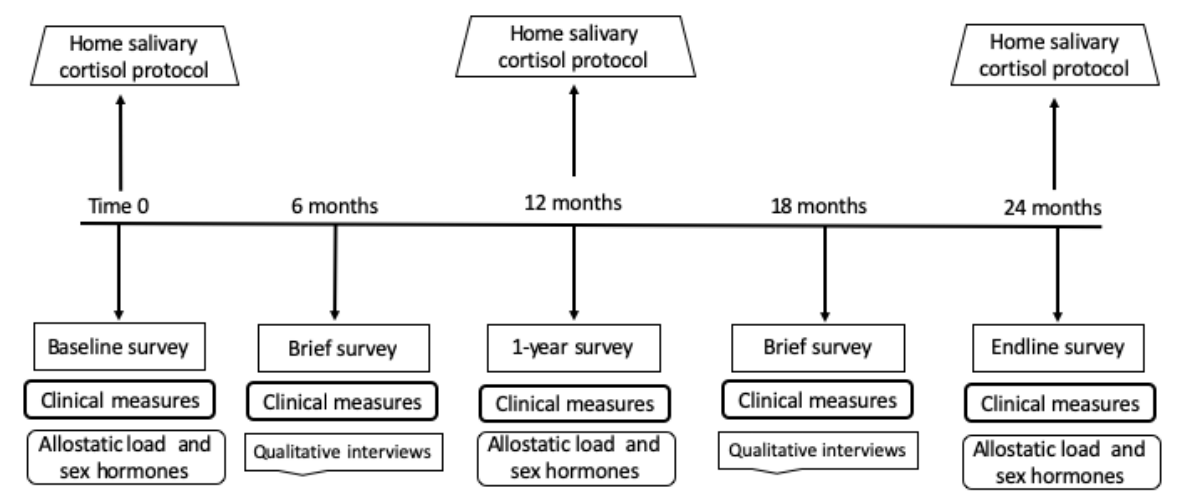
Figure 2. Overview of study visits and data collection